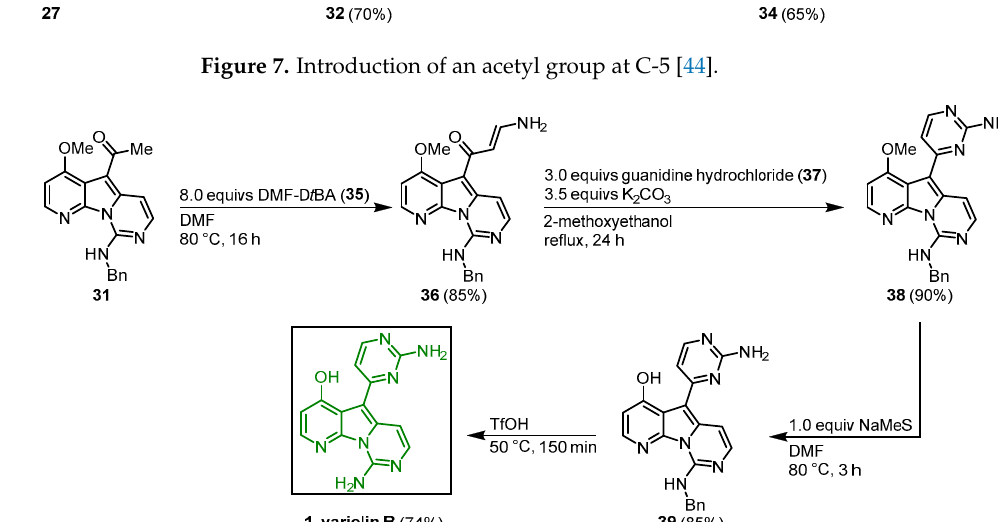
Figure 7. Introduction of an acetyl group at C-5 [44].